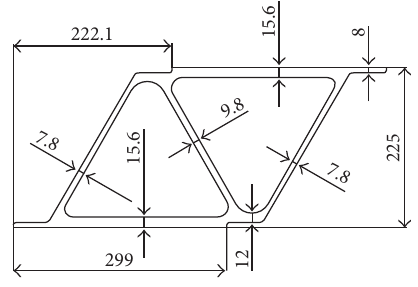
Figure 4: ASSET element.